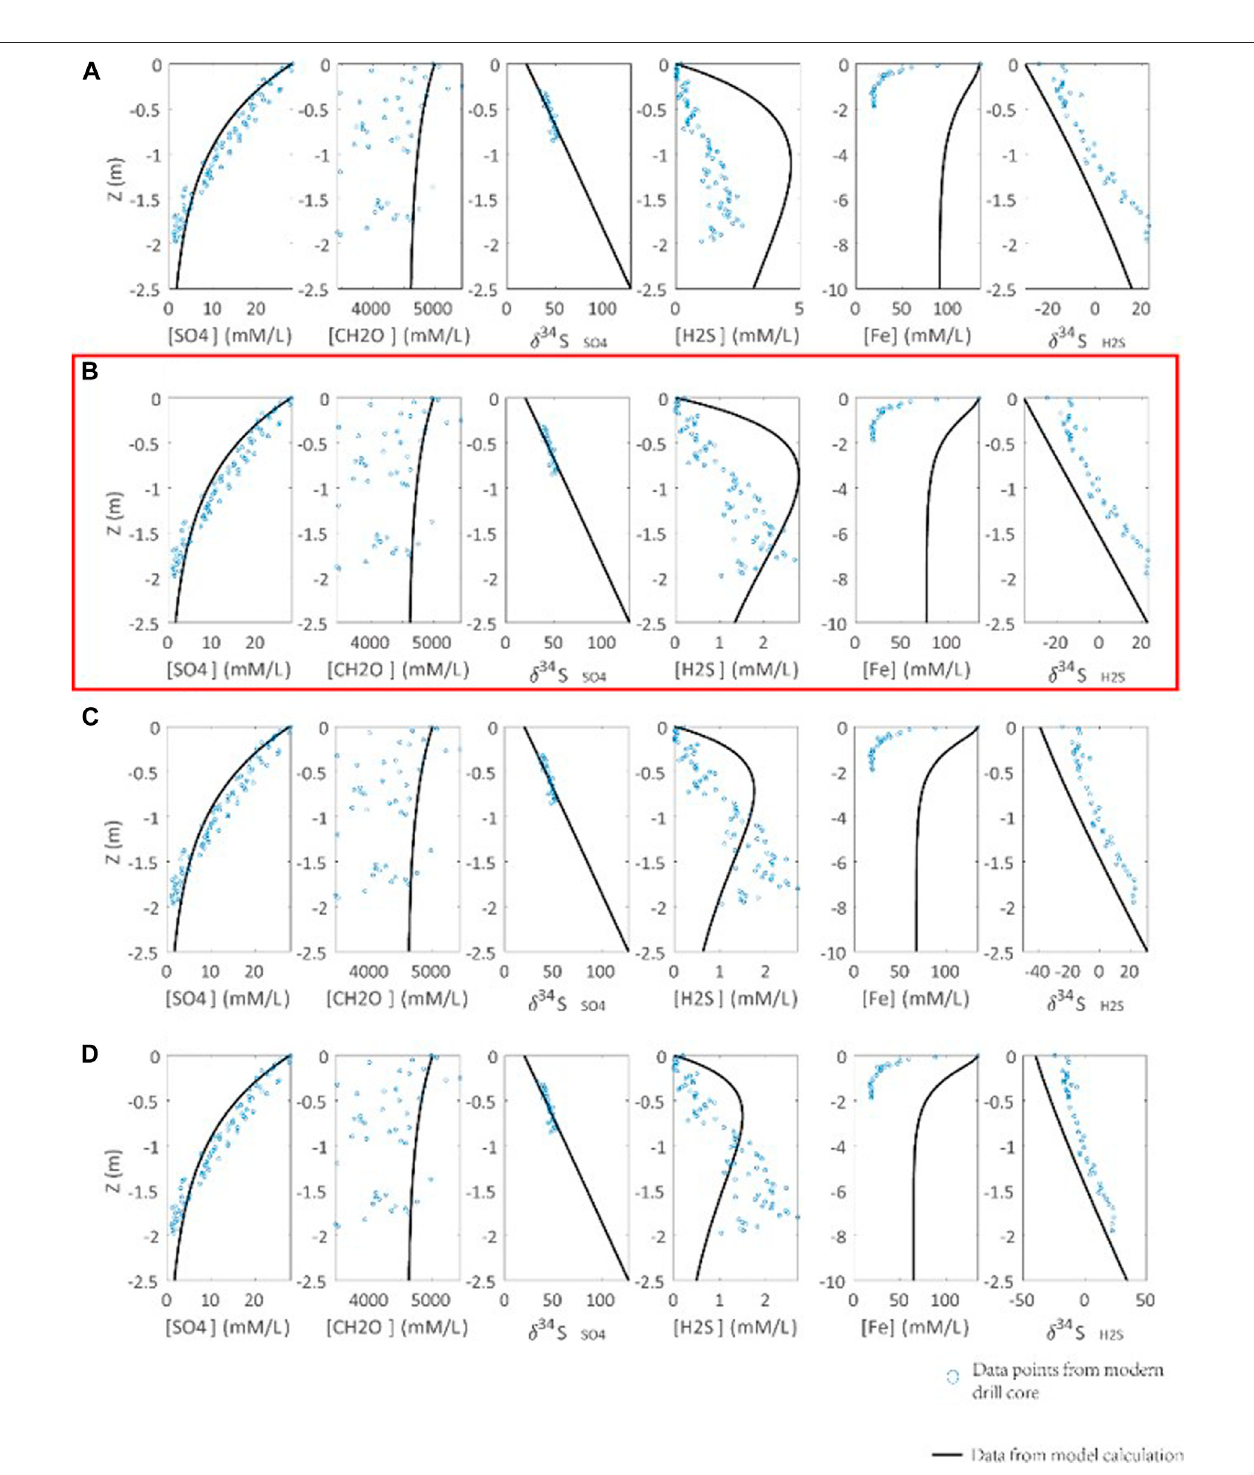
FIGURE5| Calibrationoftheseawaterredoxconditionandpyriteformationreactionconstant(R py )withanobservationfrommodernmarinesediments(Soutarand Crill,1977;Ravenetal.,2016).Parametersofcalculationsare Δ DSR (cid:1) 70 ‰ ,R DSR (cid:1) 0.0033[(mM/L)*ka] − 1 .R py issetto (A) 0.1, (B) 0.3, (C) 0.5, (D) 0.7[(mM/L)*ka] − 1 .Blue points are data points of observation from the modern drill core. Concentration and S isotope composition pro fi le of H 2 S cannot be well simulated by our model, due to simpli fi cation of oxidation mechanism of H 2 S. We choose R py (cid:1) 0.3 [(mM/L)*ka] − 1 in (B) to represent seawater redox condition of O 2 < 10 uM in modern drill core (highlighted by red